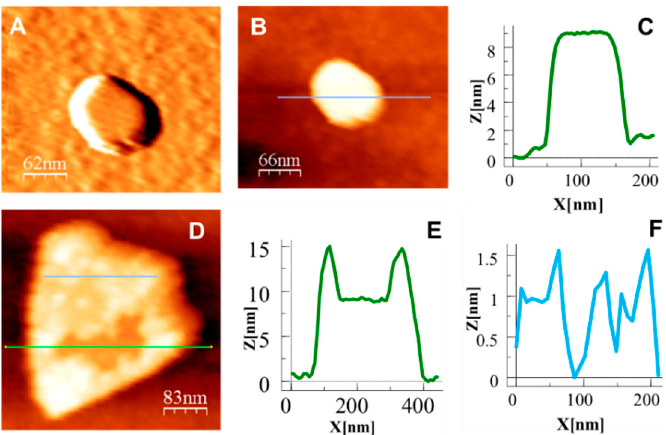
Figure 5. AFM analysis of an aqueous suspension of NiAl–LDH material drop-casted on SiO 2 substrate. ( A ) Topographic and ( B ) derivate images showing its characteristic structural features; and ( C ) height profile of the nanosheet; ( D ) AFM topography image of the 1D/2D hybrid nanomaterial and ( E , F ) its height profile analysis.